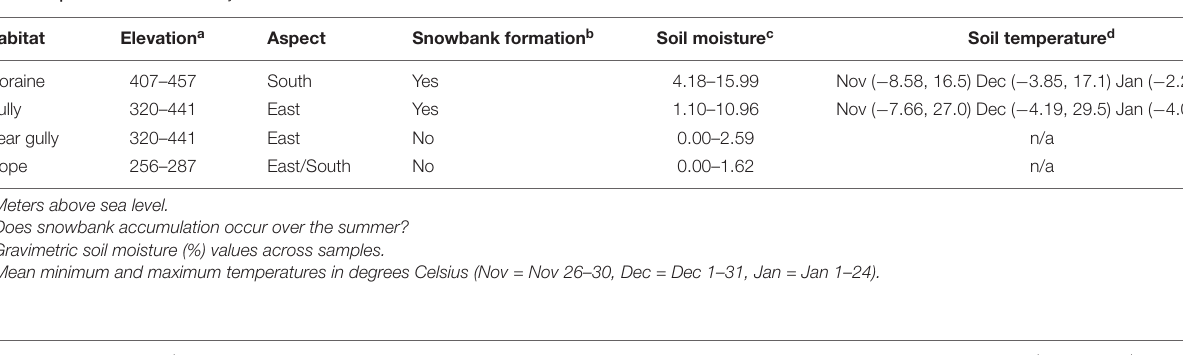
TABLE 1 | Environmental data by